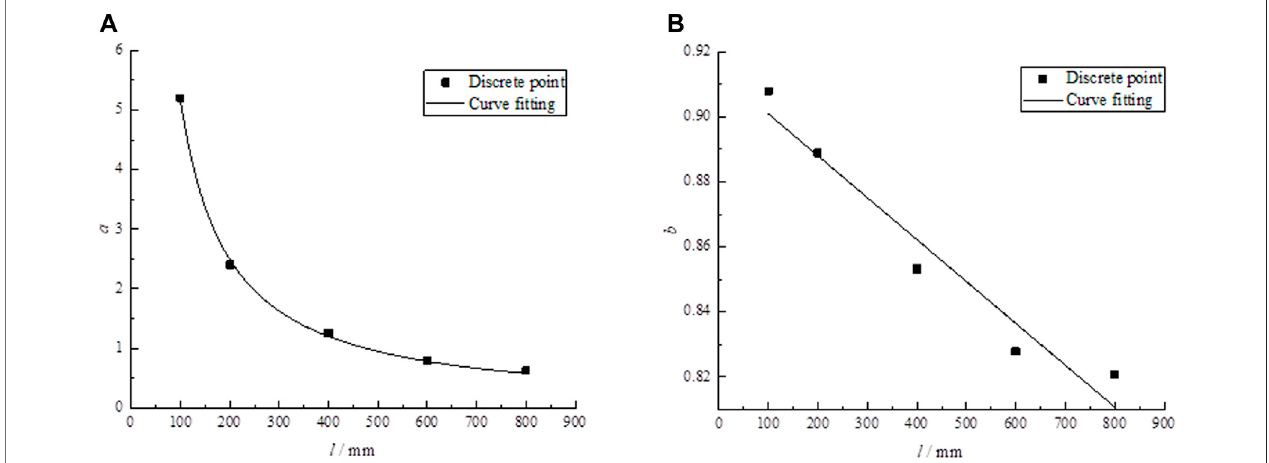
FIGURE 3 | Fitting curve diagram of parameter. (A) parameter a, (B) parameter